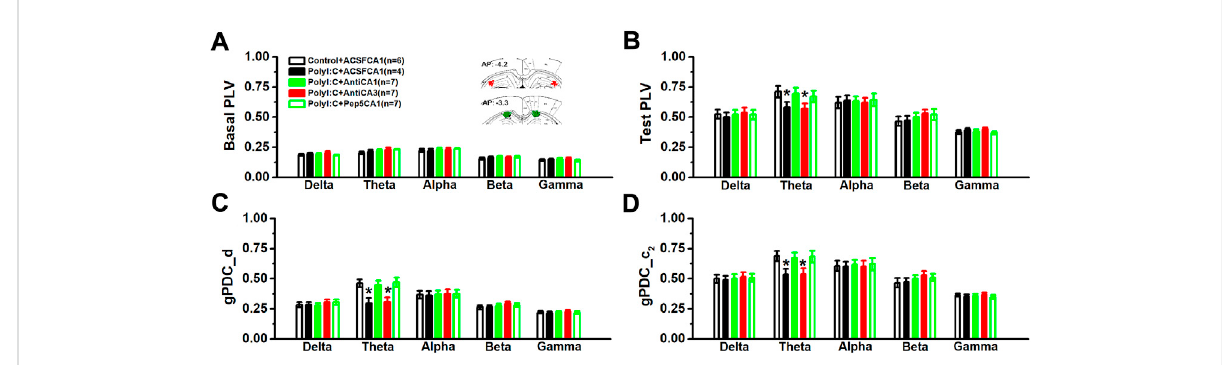
FIGURE 3 The values of PLV and the directional coupling index d and c 2 between CA3 and CA1 regions. The basal value of PLV before behavioral test (A) and the PLV value during the contextual memory test (B) . The inset showing approximate locations of electrodes. Images are adapted from The rat brain atlas in stereotaxic coordinates (122, 123). Coupling direction index d between CA1 and CA3 (C) and unidirectional in fl uence index c 2 (D) . Data arepresentedasmean±SEM.* p < 0.05,vs.Control+ACSFCA1,PolyI:C+AntiCA1andPolyI:C+Pep5CA1.Control+ACSFCA1: n =6;PolyI:C+ ACSFCA1: n = 4; PolyI:C + AntiCA1: n = 7; PolyI:C + AntiCA3: n = 7; PolyI:C + Pep5CA1: n =